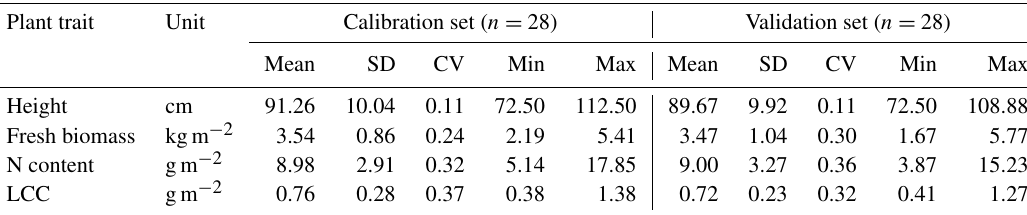
Table 2. Summary of descriptive statistics for all plant traits measured in the field. LCC: leaf chlorophyll content; SD: standard deviation; CV: coefficient of variation.